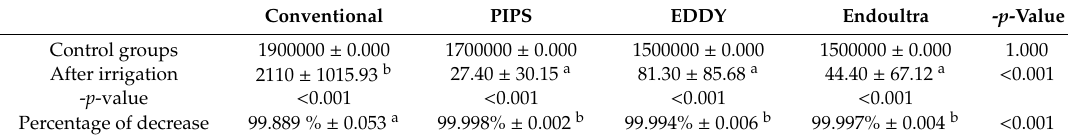
Table 1. Mean and Standard deviation of colony forming unit (CFU) in each group.